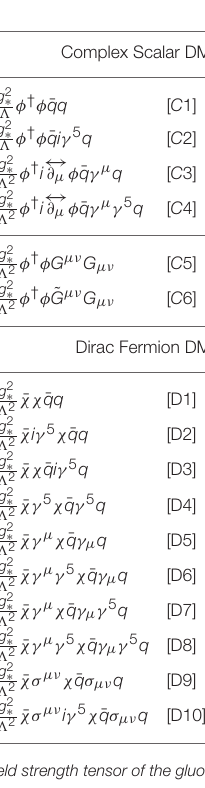
Frontiers in Physics | www.frontiersin.org